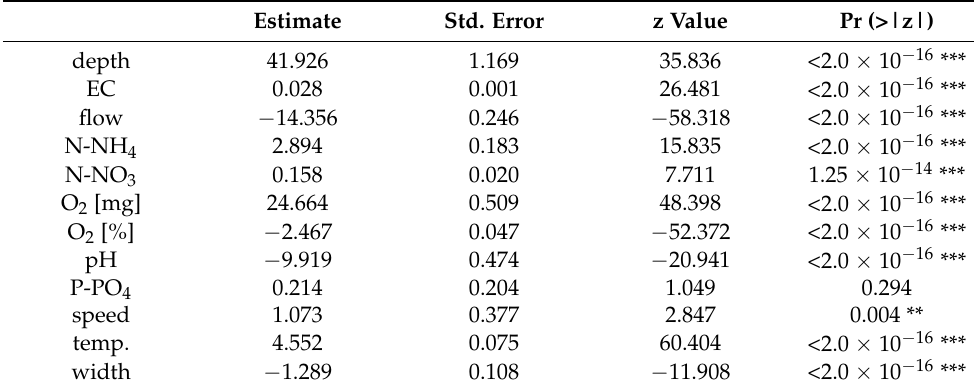
Table 3. Results of the GLM model for total density of taxa in the surveyed sites. Estimate Std.